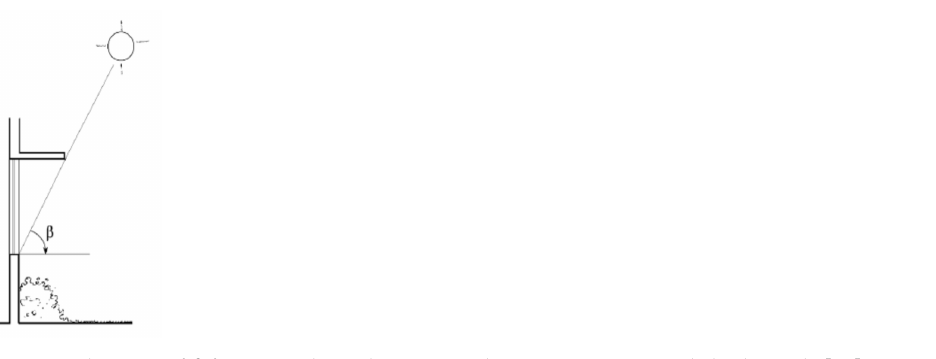
Figure 6. Indication of ß for vertical window. Vertical section—Horizontal shade angle